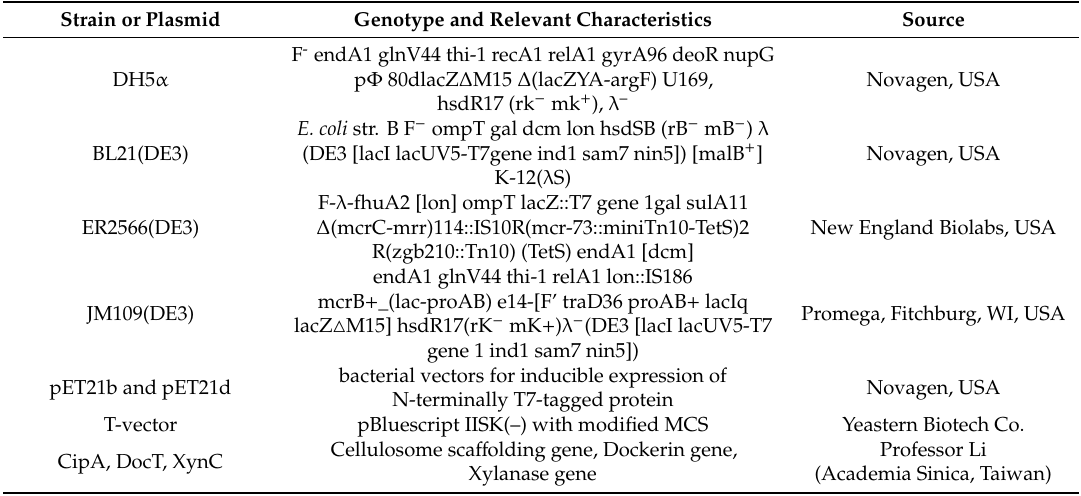
Table 2. E. coli strains and plasmids used in this